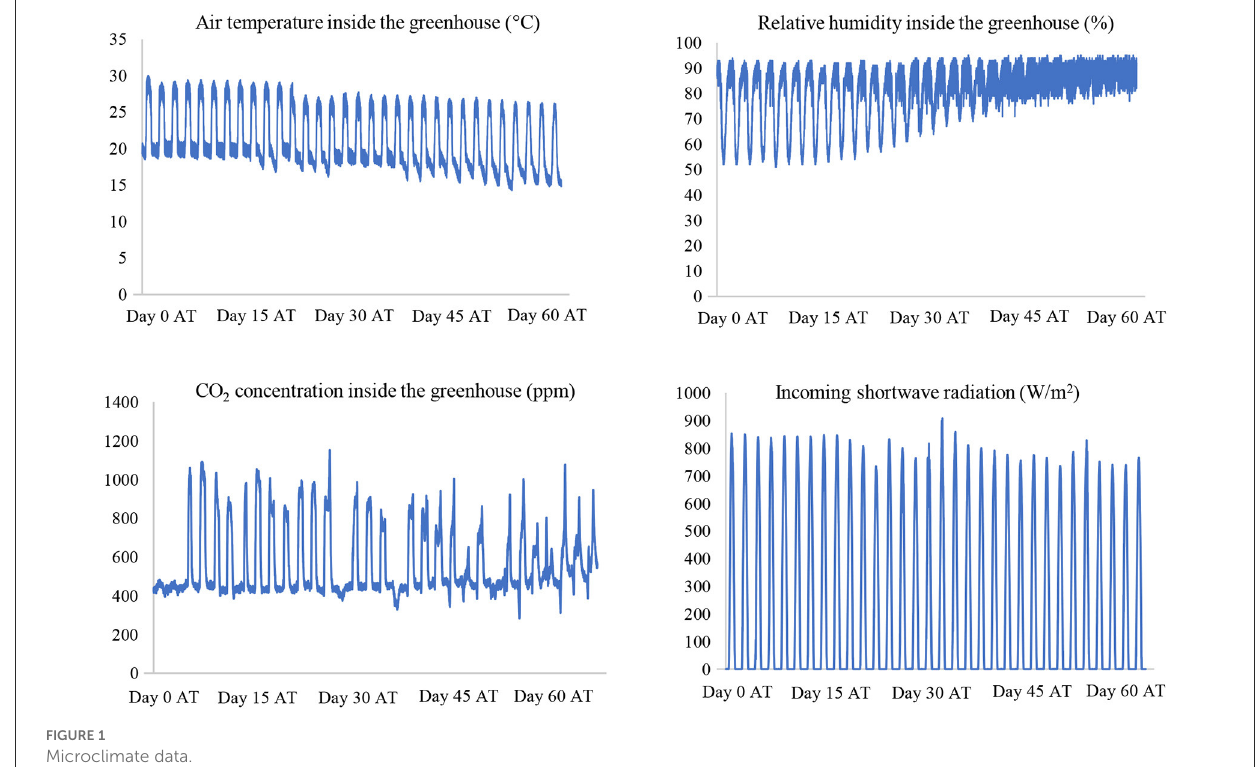
FIGURE1 Microclimate